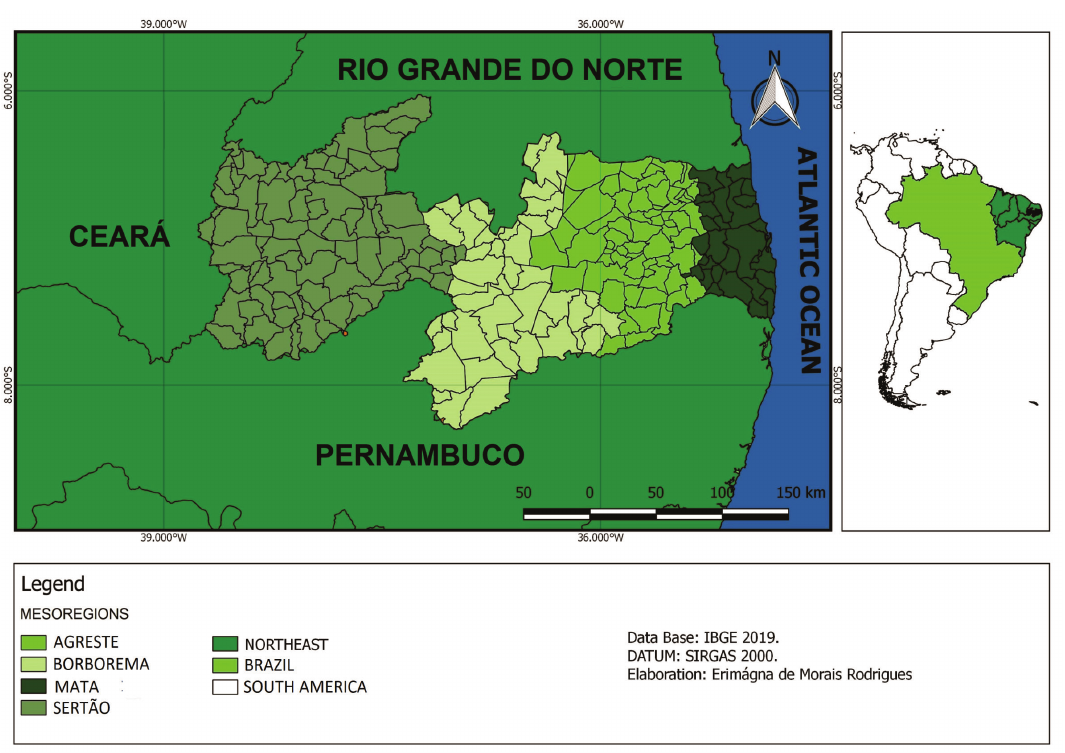
Fig. 1. Map of the study area, Paraíba State, northeastern Brazil. Maps by E. de Morais